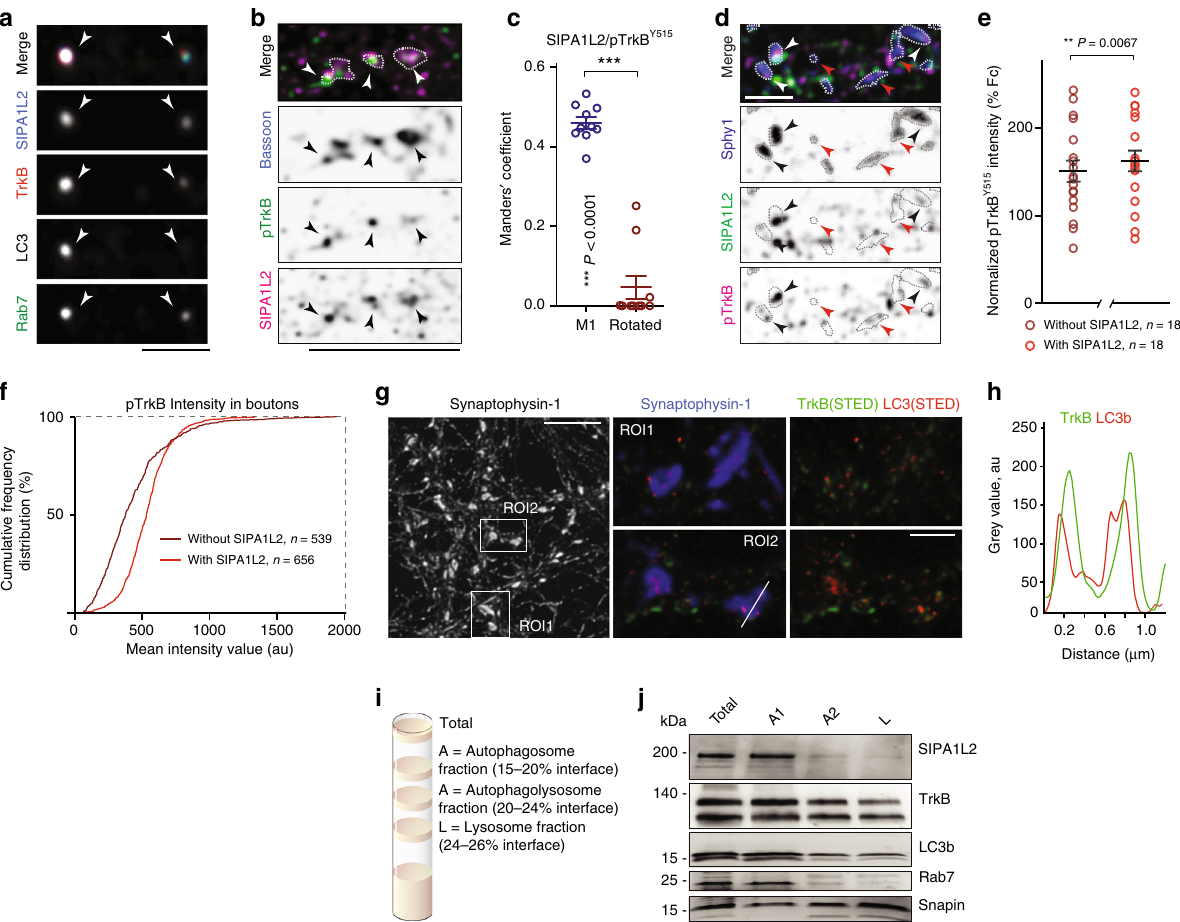
Fig. 7 TrkB-LC3b-Rab7-containing amphisomes are positive for SIPA1L2. a Confocal images of quadruple immuno fl uorescence performed in rat primary hippocampal neurons stained for SIPA1L2, LC3, TrkB with Rab7. Scale bar is 1 μ m. b Confocal images of primary neurons treated with BDNF and stained for pTrkB Y515 , SIPA1L2, and Bassoon show colocalization of SIPA1L2 and pTrkB Y515 in presynaptic boutons. Scale bar is 5 µ m. c Mander ’ s coef fi cient calculated for pTrkB Y515 and SIPA1L2 in boutons detected by Bassoon staining. For control measurements, the same images were rotated 90º to the right (paired Student ’ s t test). d , e Representative images in d of rat hippocampal neurons treated with BDNF and stained for pTrkB Y515 , SIPA1L2 and Synaptophysin1. Arrows indicate boutons where SIPA1L2 is present (black) or absent (red). Note that in the presence of SIPA1L2, pTrkB Y515 intensity is higher compared to those from boutons where SIPA1L2 is absent. Quanti fi cation is shown in e , circles represent averaged intensities per image (paired Student ’ s t test for average per image). Averaged intensities are normalized to images acquired from Fc-TrkB-treated neurons. The cumulative frequency distribution is shown in f ( n = synaptic boutons). Scale bar is 2 μ m. g , h Super-resolution STED imaging performed in rat hippocampal neurons revealed association of TrkB with LC3 at the presynaptic boutons. In h , line pro fi les from the line in the ROI2 in g . Scale bars 5 µ m (overview) and 1 µ m (inserts). i , j In i , scheme depicting fractionation protocol performed from rat brain that results in autophagosome (A1), autophagolysosome (A2) and lysosome (L) fraction. Note that Rab7 and SIPA1L2 are only present in the total and A1 fraction ( j ) according to their presence in amphisomes but not in later stages of the autophagosomal pathway. Lines in dot plot graphs depict data as mean ± SEM. "**" indicates P ≤ 0.01; "***" indicates P ≤